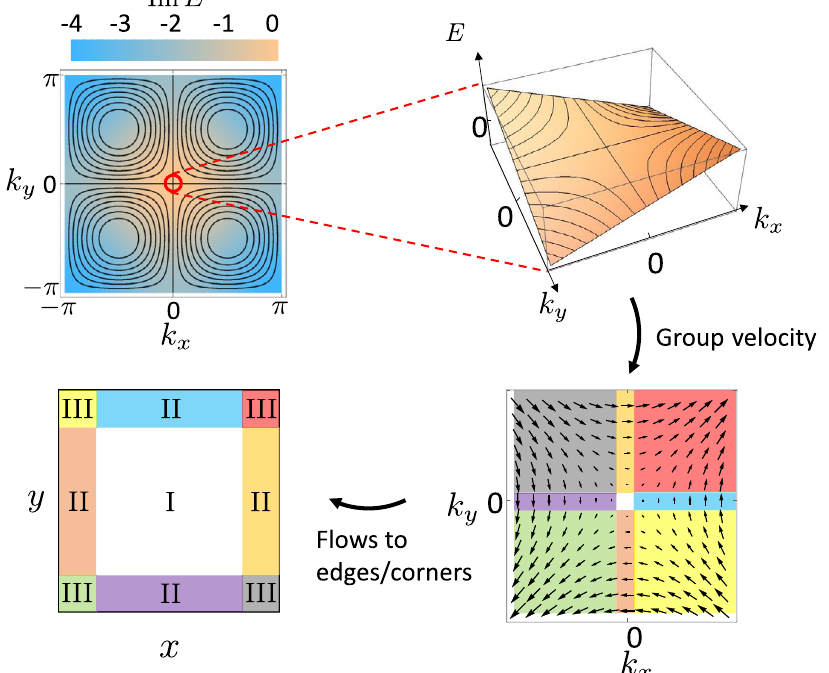
Fig. 1 | Rank-2 chiral mode as a long-lived mode of a non-Hermitian lattice Hamiltonian and the resulting rank-2 NHSE. The top left panel shows the iso- energy contours of Re E = sin k x sin k y (black lines) and the loss Im E = cos k x + cos k y (cid:2) 2. The top right panel manifests the dispersion of long- livedrank-2chiralmodearound Γ =(0,0).Thegroupvelocity fi eldofthelong-lived